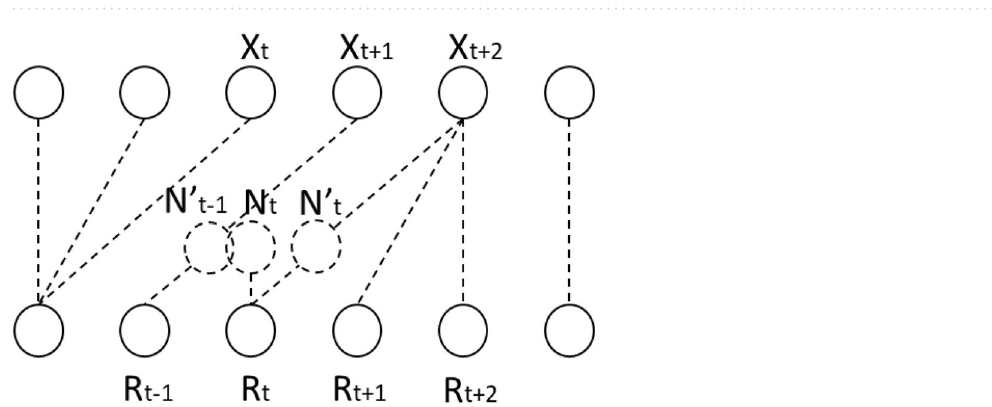
Figure 2. Conceptual diagrams showing the use of SOM to: ( a ) discover multipollutant patterns, as in Pierce et al. (2014); and ( b ) diurnal patterns of a single pollutant, as proposed in this study.